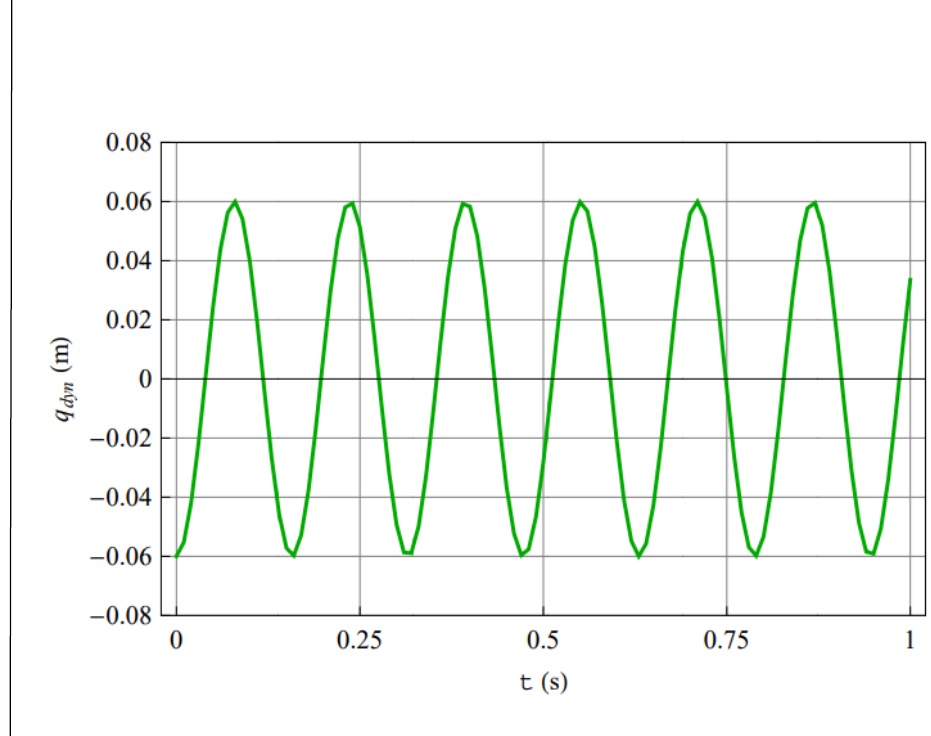
Figure 2 – Response – displacement of the middle of the bridge Рис. 2 – Ответ - смещение середины моста Слика 2 – Одговор – померање средине